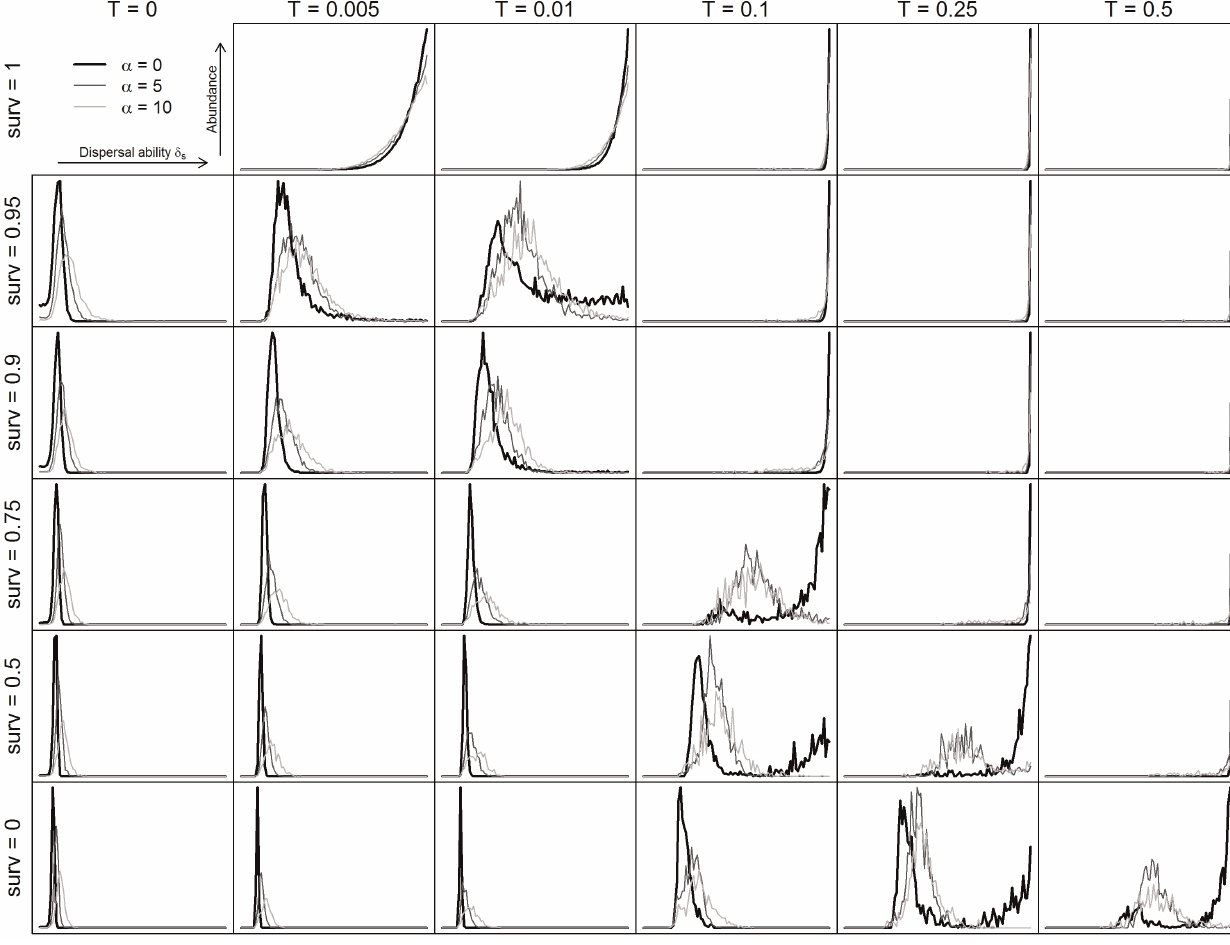
Figure 4. Abundance of all the dispersal strategies for the generalist species. Mean abundances of the 101 generalist species ( s s =0.5), computed on the n=50 replicates, as a function of species dispersal ability, across the various values of adult survival rate y s and disturbance rate T. Thick black line: a =0; thin black line: a =5; grey line: a =10. Results for the specialist species are presented in Figure S2.